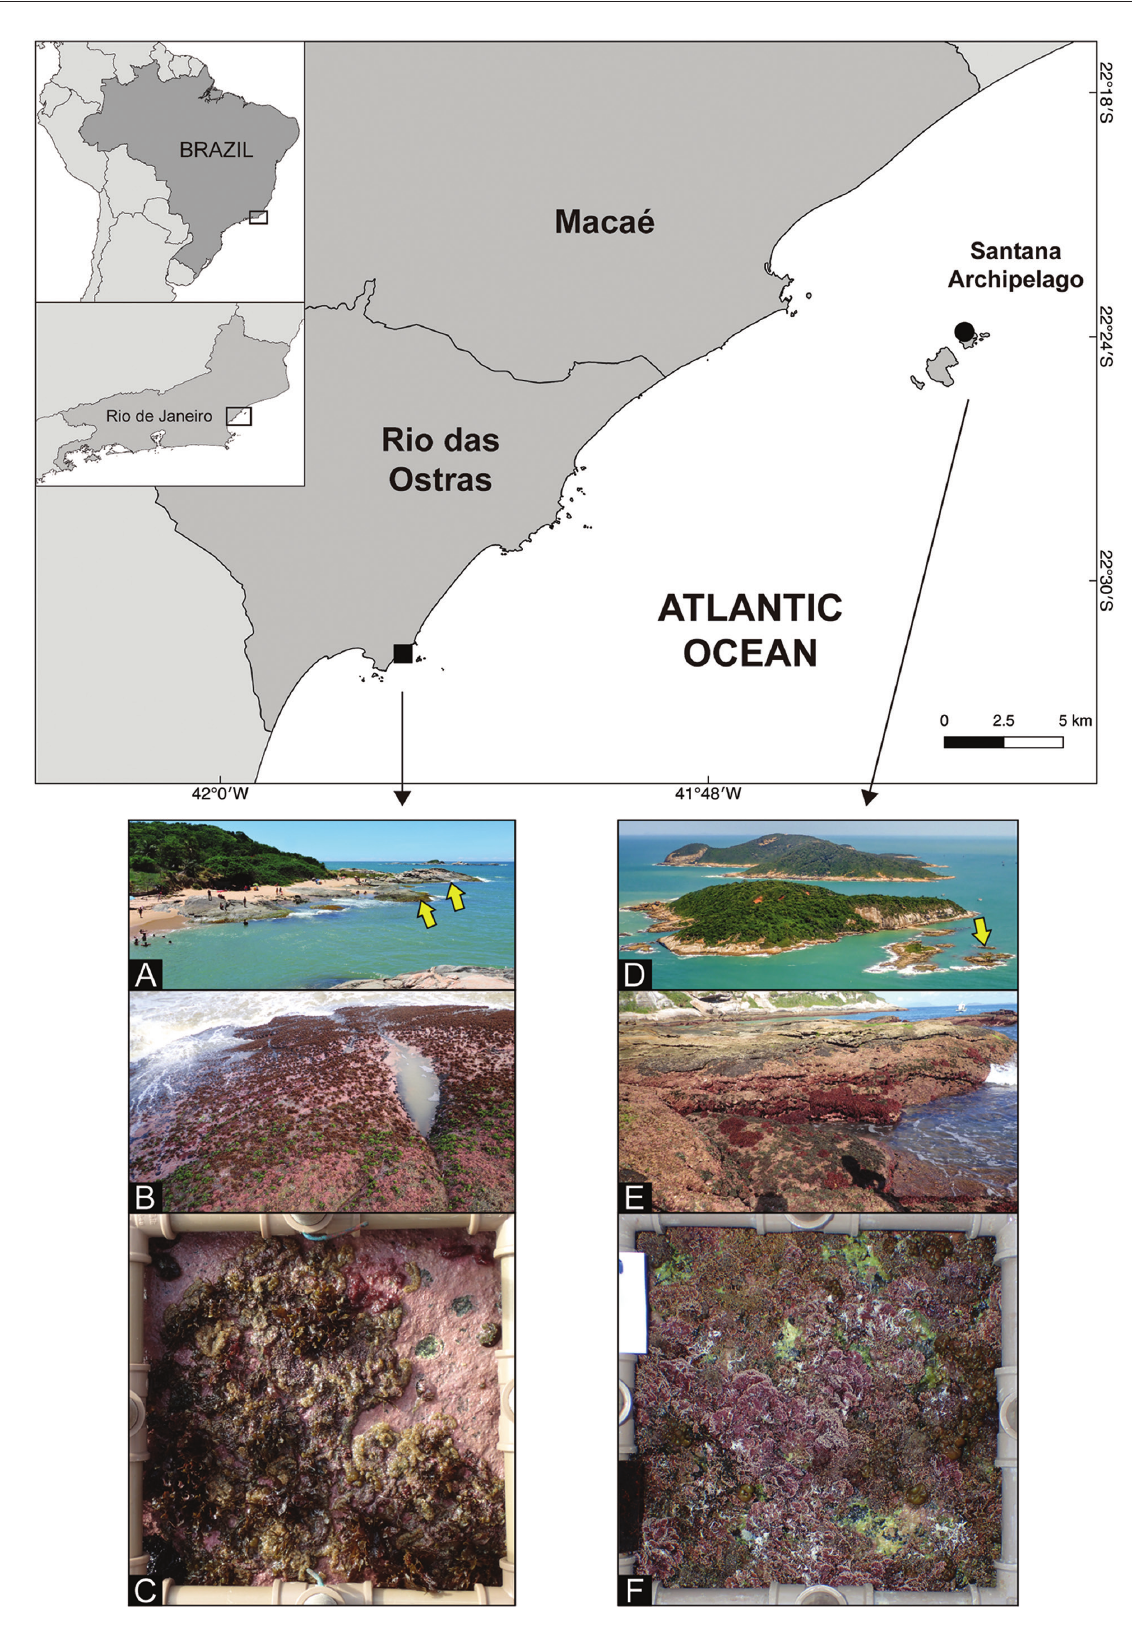
Figure 13. Geographic distribution of Apseudomorpha brasiliensis sp. nov. (circle) and Pseudozeuxo fischeri sp. nov. (square) on the study area. A–C Areias Negras Beach, Rio das Ostras. A General view of Areias Negras Beach; B view of the rocky shore eulittoral site; C view of the quadrat sample and seaweed cover; D–F Santana Archipelago, Macaé; D General view of Santana Archipelago; E view of the rocky shore eulittoral site; F view of the quadrat sample and seaweed cover. Program: QGIS 2.16.3 SRC: EPS4326